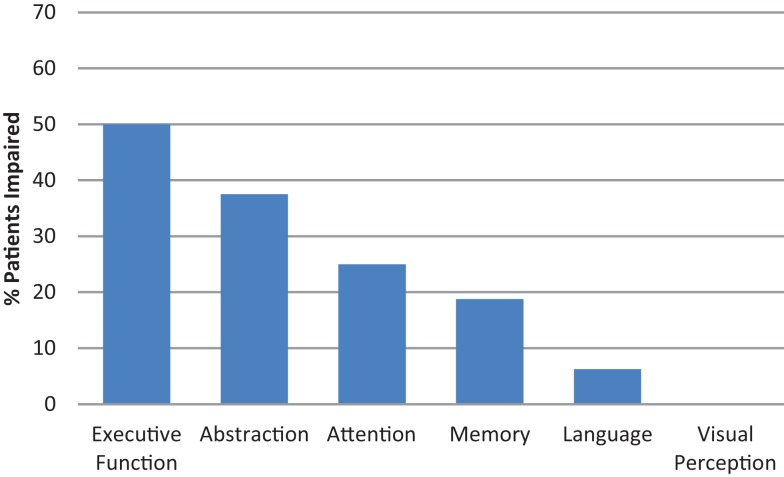
Cognitive assessment: MoCA-Intact participants impaired in domain-specific cognitive tests.